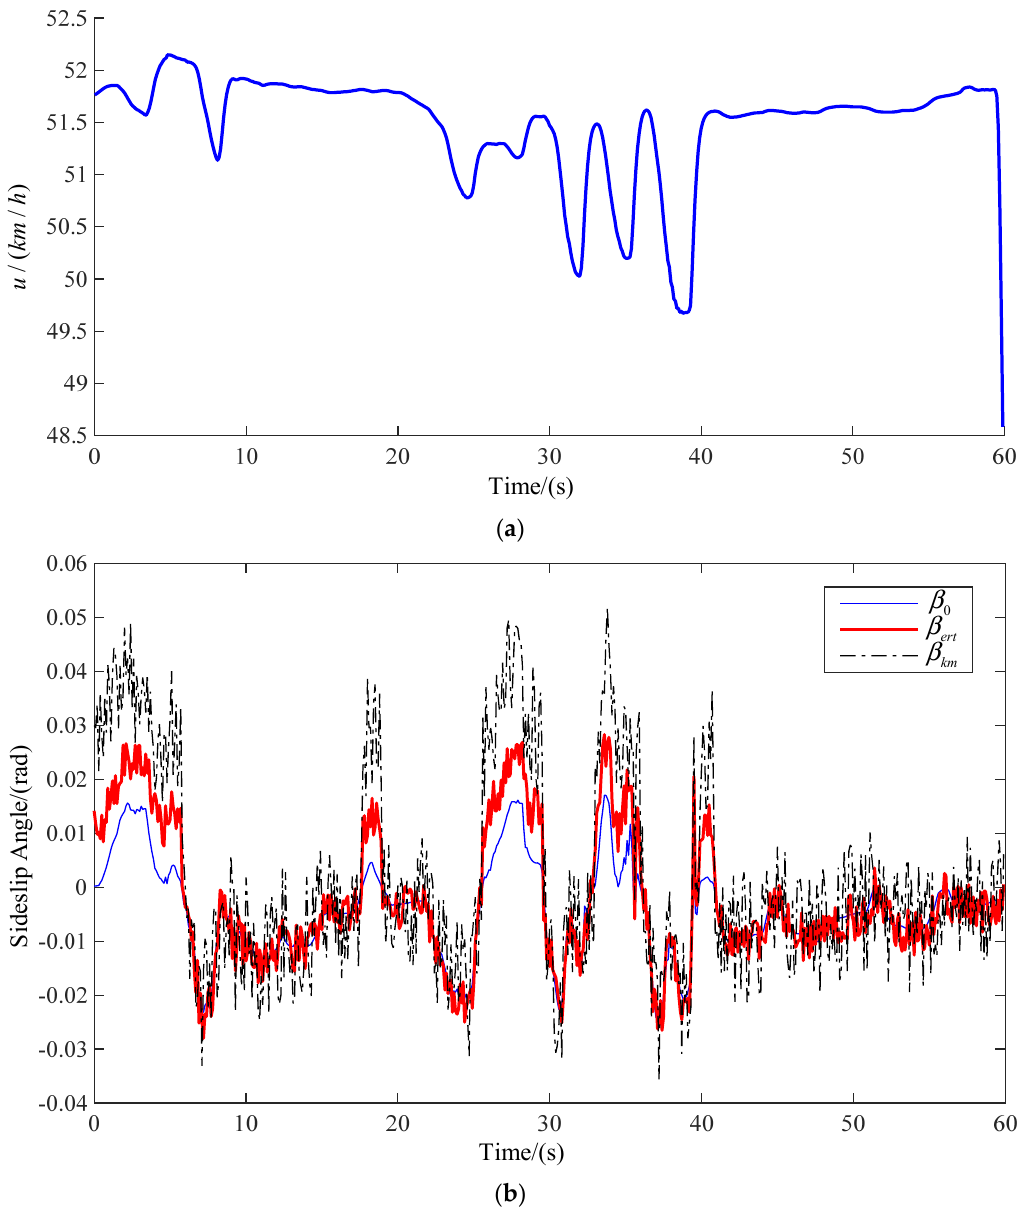
15 of 20 Figure 7. Vehicle real travel trajectories. ( a ) The track at moderate and low speed; ( b ) track at mod- erate and high speed; ( c ) track at high speed. The road model selected in this paper includes many simple working conditions, and can be used to verify and analyze the method proposed in this paper comprehensively. The real − time speed and vehicle sideslip angle at three speeds are observed. The observa- tion results are shown in Figures 8 − 10, respectively, corresponding to Figures 7a − c. The